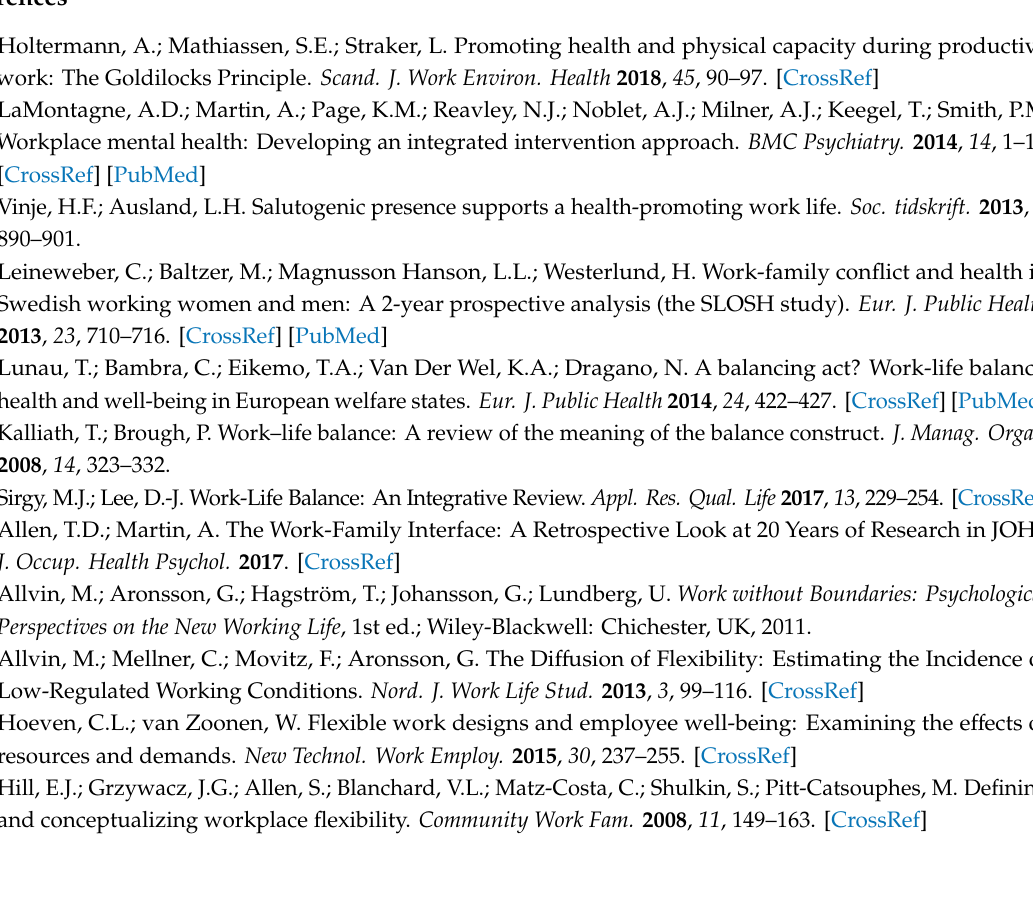
Table S1: Description of included questions in all independent variables used in the present